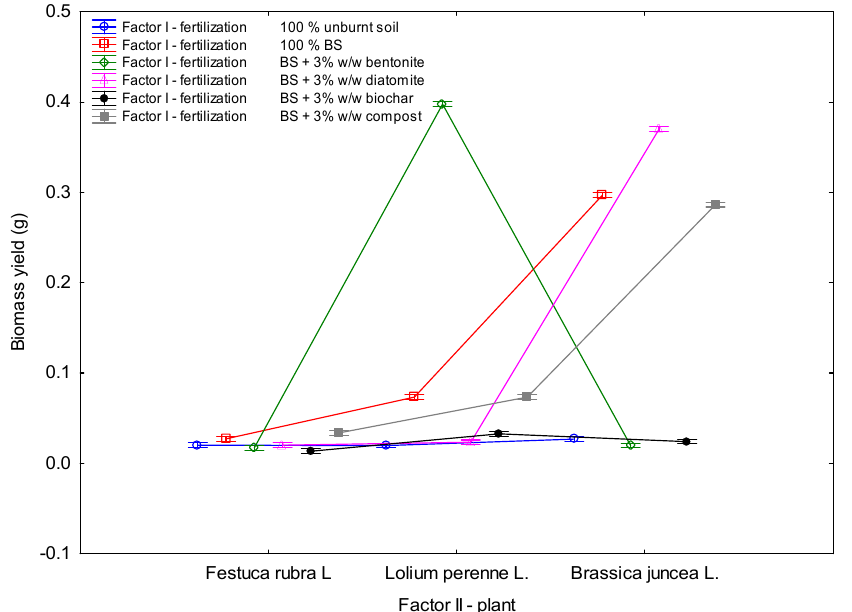
Figure A1. Graphical illustration of the effect of individual factors on the aboveground biomass yield.